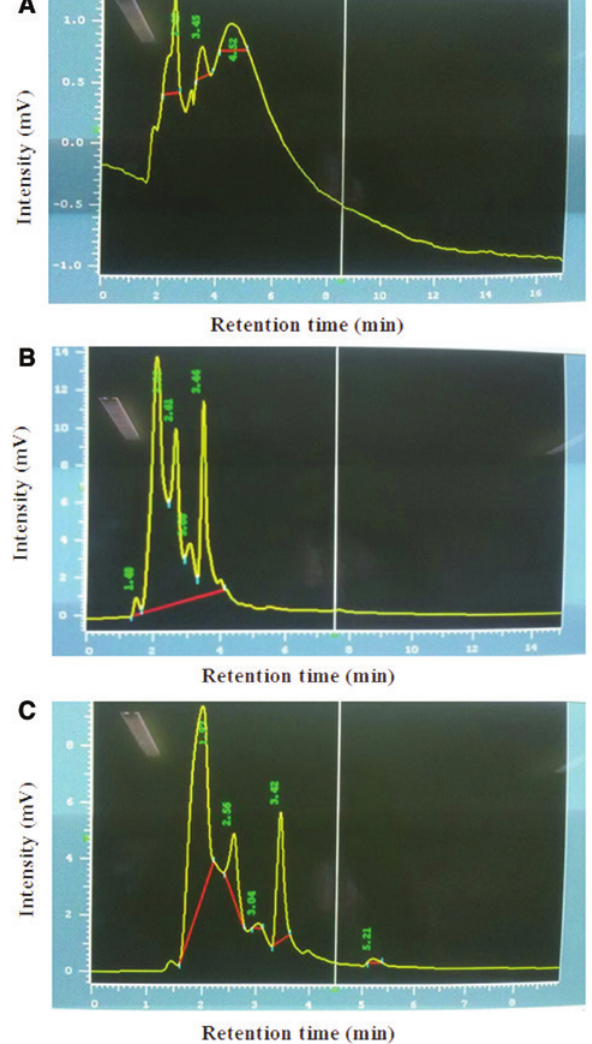
Figure 7: High performance liquid chromatography (HPLC) chroma- tograms of the saponin extracts obtained using (A) microwave, (B) autoclave and (C) Bain-Marie heating